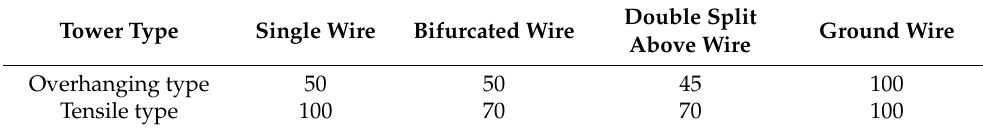
Double Split Ground Wire Above Wire